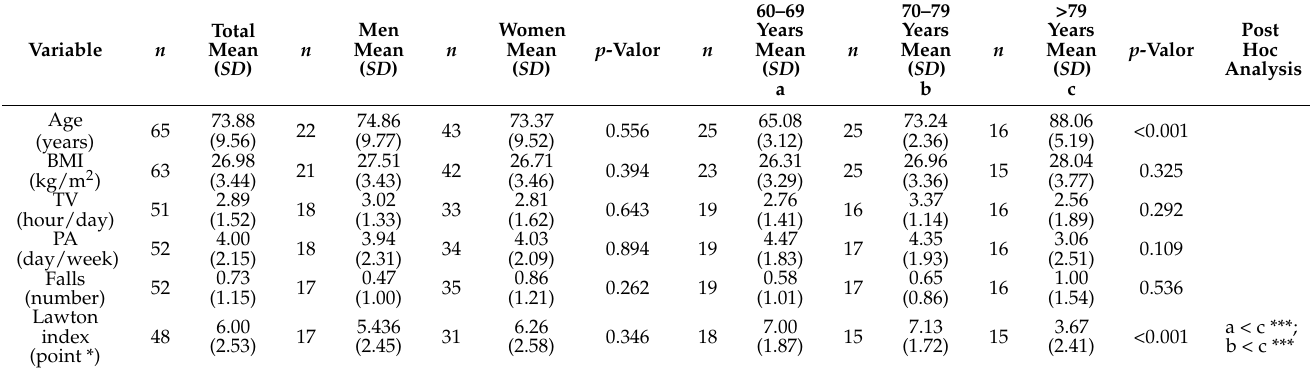
Table 1. General characteristics of the participants divided by sex and age